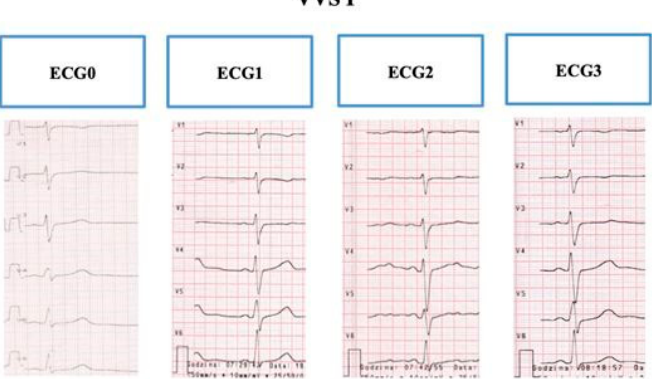
Figure 1. The sample electrocardiogram of a child with vasovagal syncope with variable T-wave morphology (VVSI) recorded on admission to the ward and in the three phases of the tilt test: two-humid T-waves are visible in a 2-phase electrocardiogram (after standing) in V4-V6 leads. Source: the medical documentation of a child with children with vasovagal syncope, hospitalized at the Children’s Cardiology